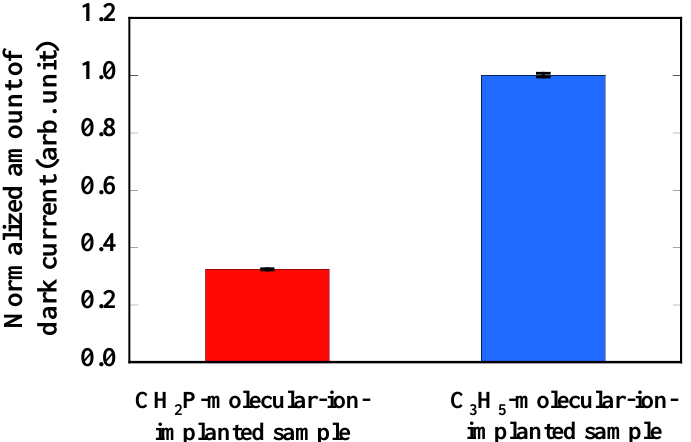
Figure 4. Normalized amount of dark current for CMOS image sensors fabricated with CH 2 P- and C 3 H 5 -molecular-ion-implanted epitaxial silicon wafers.